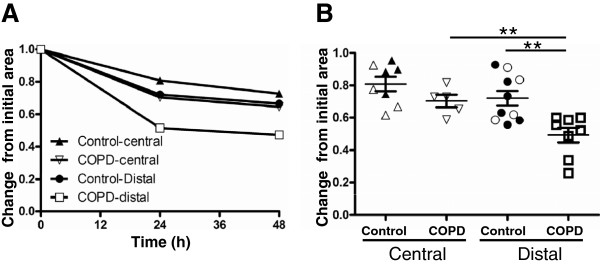
Collagen gel contraction. (A) The contractile potential of the isolated fibroblasts was monitored in collagen contraction gels over time by comparing gel areas of each time point by the initial gel areas. Each point represents the mean of each study group. (B) Contractile potential of isolated fibroblasts after 24 hours compared to the initial area. Open symbols represents fibroblasts isolated from lung explants and closed symbols fibroblasts isolated from lung biopsies. **P < 0.01.